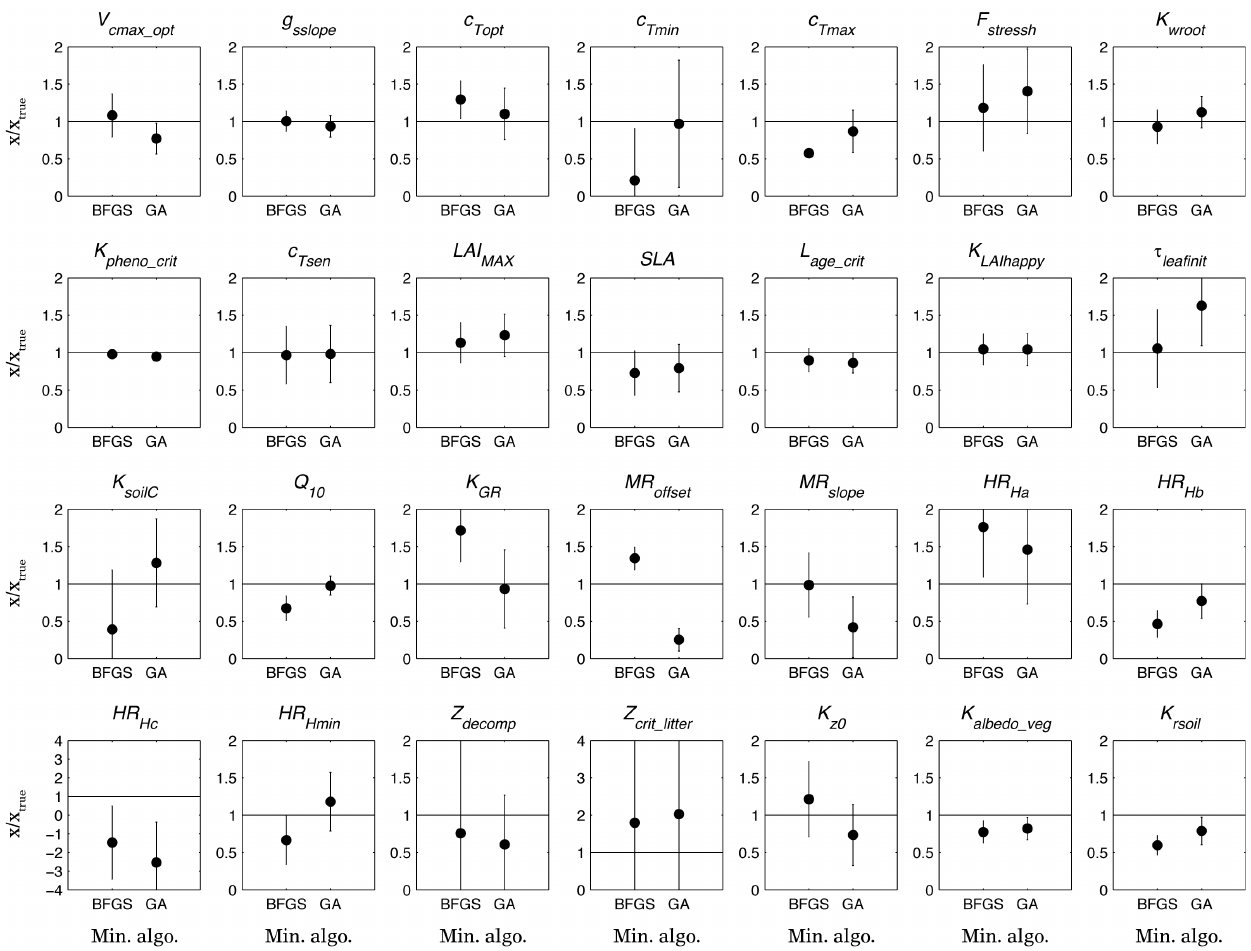
Figure 2. Twin experiments results in terms of parameter inversion. For each parameter, the retrieved values ( x ) corresponding to the best realization of each minimization algorithm (Min. algo.: BFGS, GA) are divided by the true values ( x true ) that were used to generate the data so that a value of 1 indicates a perfect retrieval (horizontal lines within the boxes). Along with these values are the a posteriori uncertainties normalized to the true parameter